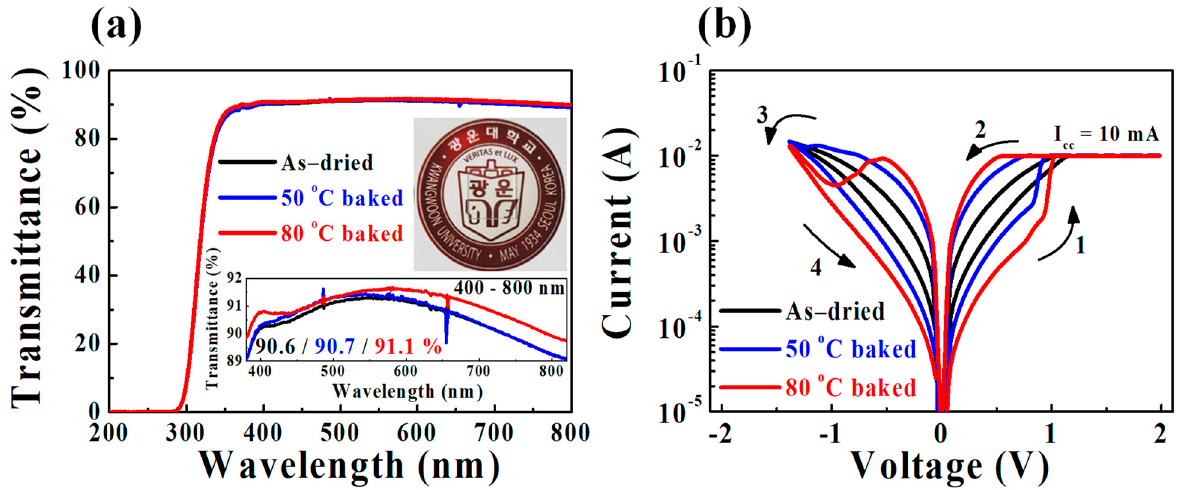
Figure 1. ( a ) Optical transmittance spectra of as-dried, 50 °C baked, and 80 °C baked solid polymer electrolyte (SPE)- chitosan layers on the glass substrate. The insets show the transmittance spectra in the visible light wavelength region (400–800 nm) and a photograph of the 80 °C baked SPE-chitosan layer. ( b ) Bipolar resistive switching (BRS) I - V character- istics of as-dried, 50 °C baked, and 80 °C baked SPE-chitosan memristors.